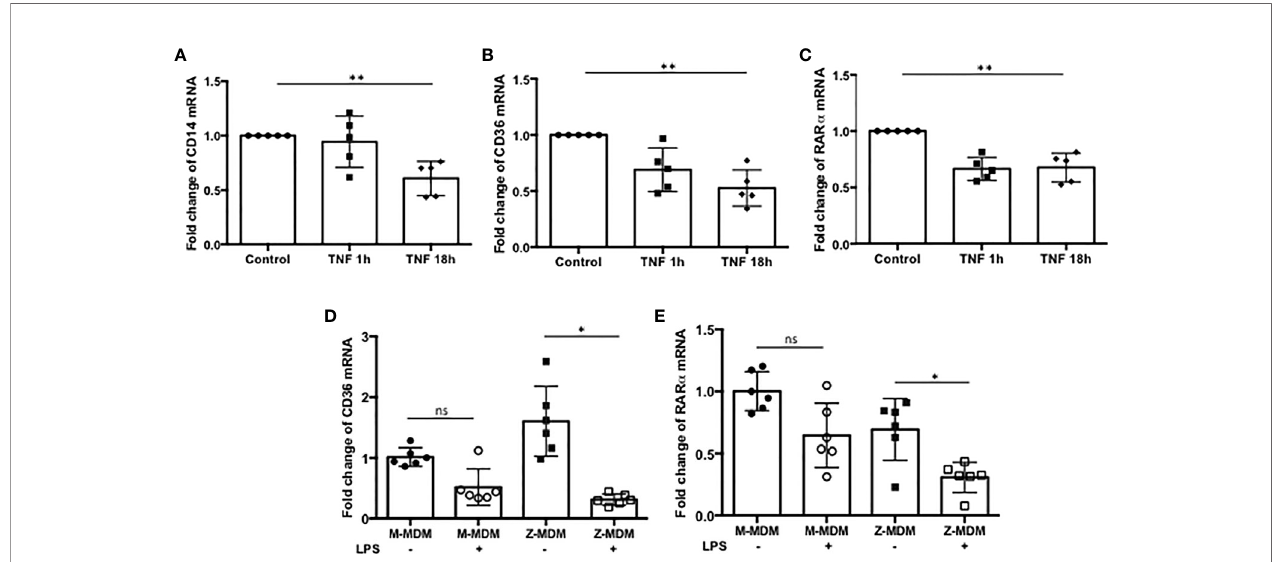
FIGURE 9 | The expression of efferocytosis-related genes regulated by TNF a . MDMs were incubated with TNF a (10 ng/ml) for 1 and 18 h, and the expressions of (A) CD14, (B) CD36, and (C) RAR a were examined in the cells (n=5). **Denotes statistical signi fi cance (p-value < 0.01) according to one-way ANOVA test. MDMs were incubated with LPS (10 ng/ml) overnight and the relative expression levels of (D) CD36, and (E) RAR a were calculated in comparison to non-treated controls for M-MDMs and Z-MDMs (n=6). *Denotes statistical signi fi cance (p-value < 0.05) according to two-tailed Student ’ s